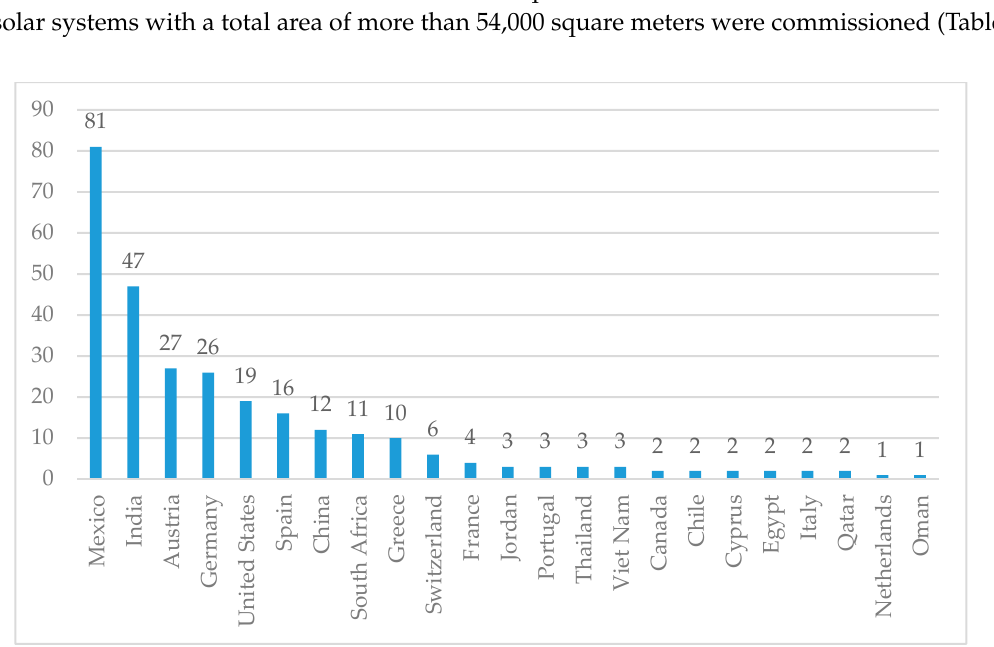
Figure 3. The number of industrial collectors with a capacity of at least 700 kW in different countries of the world in March 2019 [23]. Table 2. Statistics of installations of industrial solar collectors by country in 2017–2018, [15,23]. Country